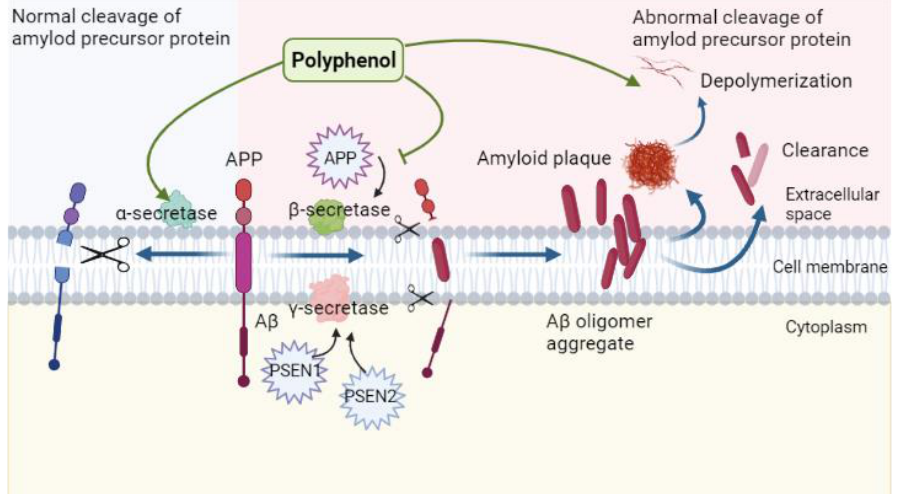
Figure 4. Regulatory role of polyphenols in the context of amyloid neurotoxicity: polyphenols allow cleavage of Aβ correctly by promoting the activity of α - secretase, inhibit the activities of β - , and γ - secretases, prevent erroneous cleavage, promote Aβ plaque depolymerization and clearance, and reduces its neurotoxicity.